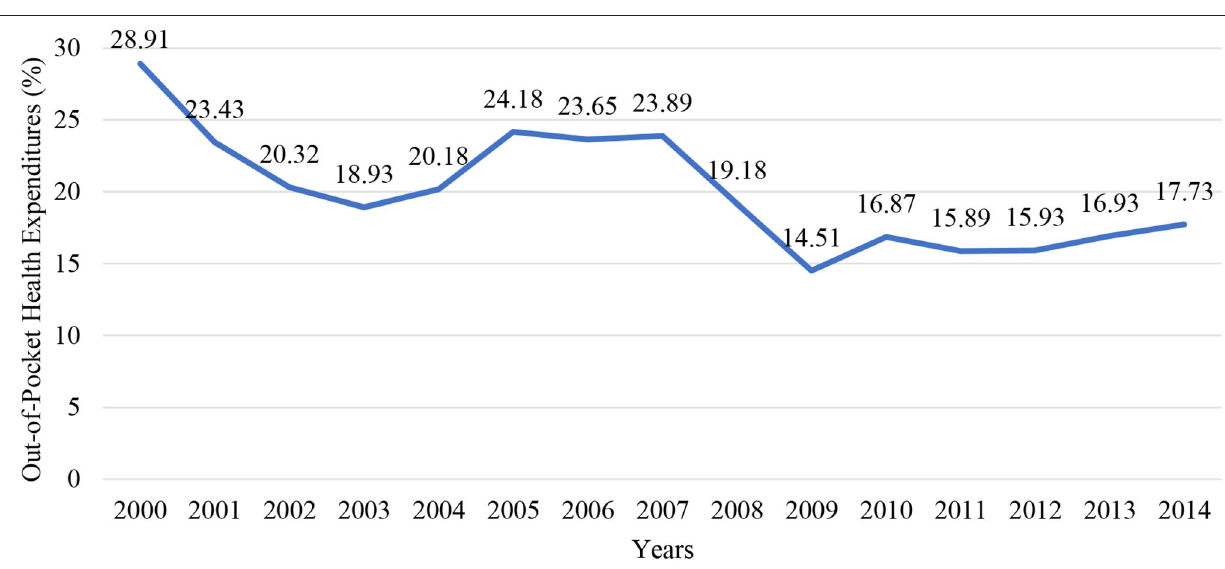
FIGURE 3 | Percentage (%) of out of pocket health expenditures by years